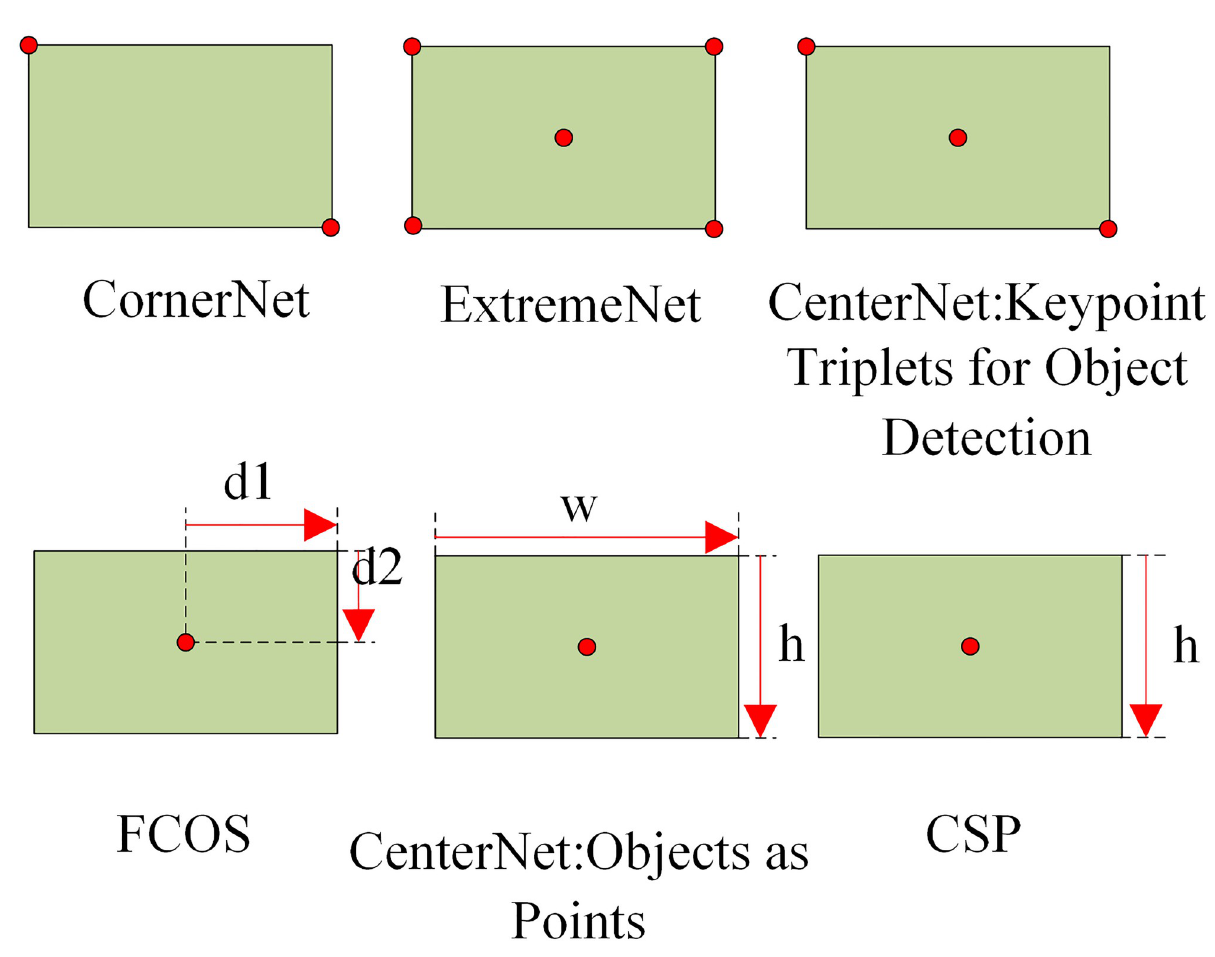
Fig 2. Predictive approach of anchor-free